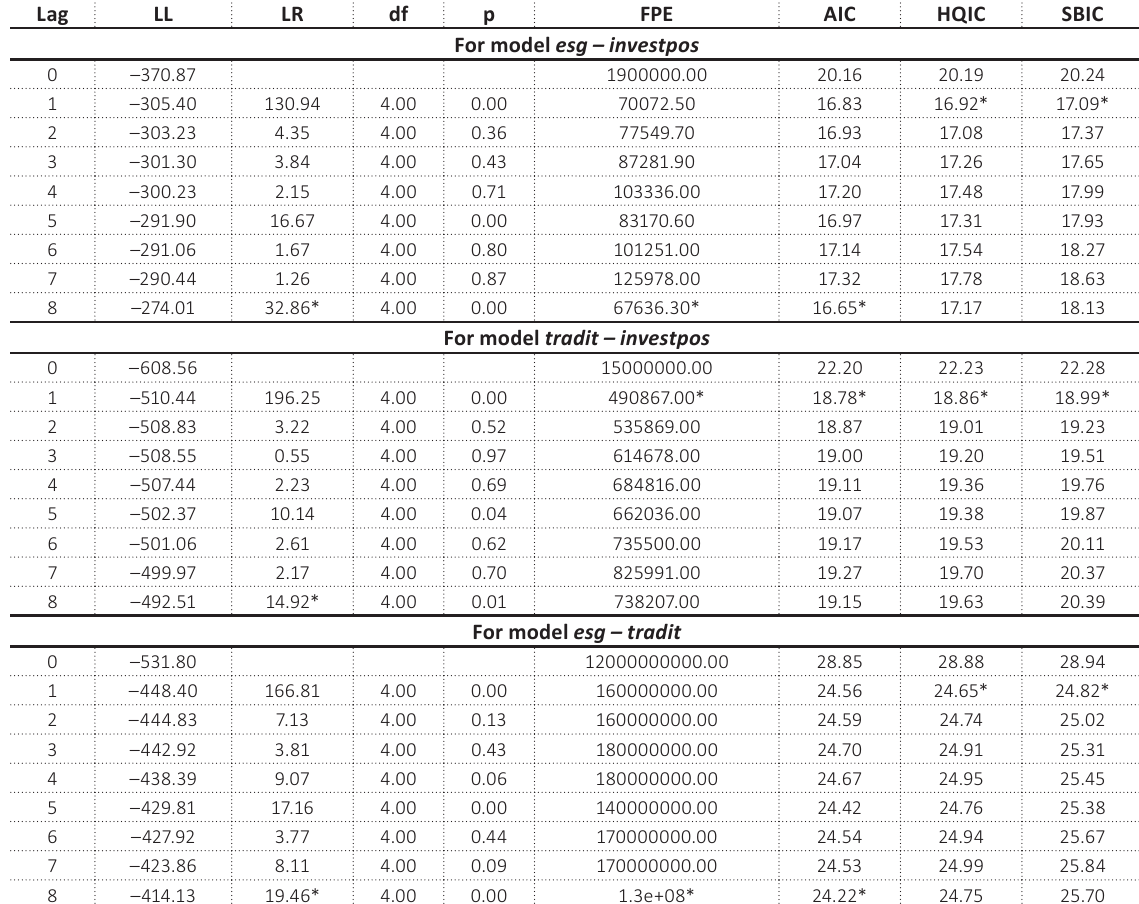
Table 10. Selecting the optimal number of lags for time series in France Lag LL LR